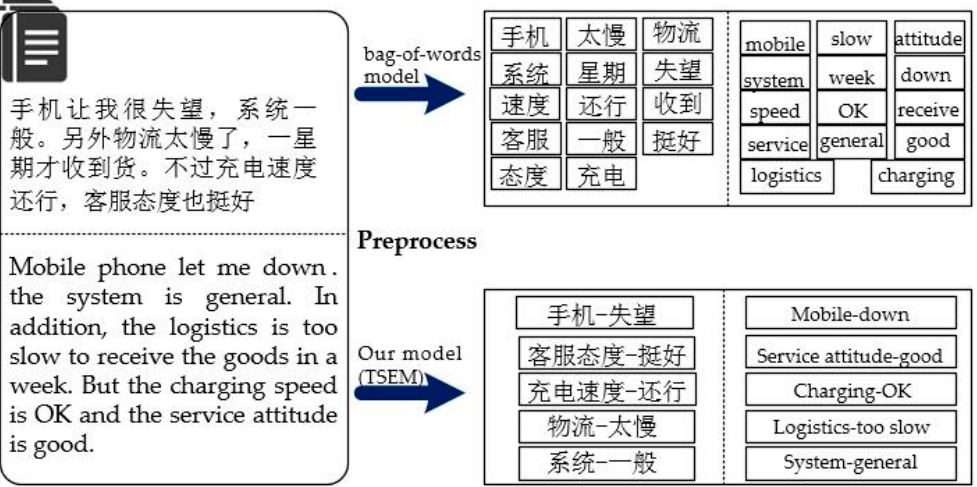
Figure 3. Representation of text by a traditional word bag model and the Topic-Specific Emotion Mining (TSEM) model.